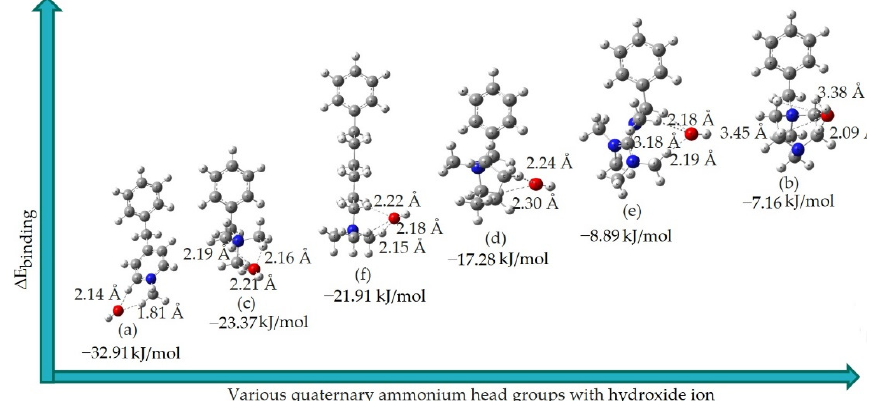
Figure 4. Complexes of six different QA head groups with hydroxide ions in the presence of implicit water. Color key: white (hydrogen); grey (carbon); blue (nitrogen); green (chloride).